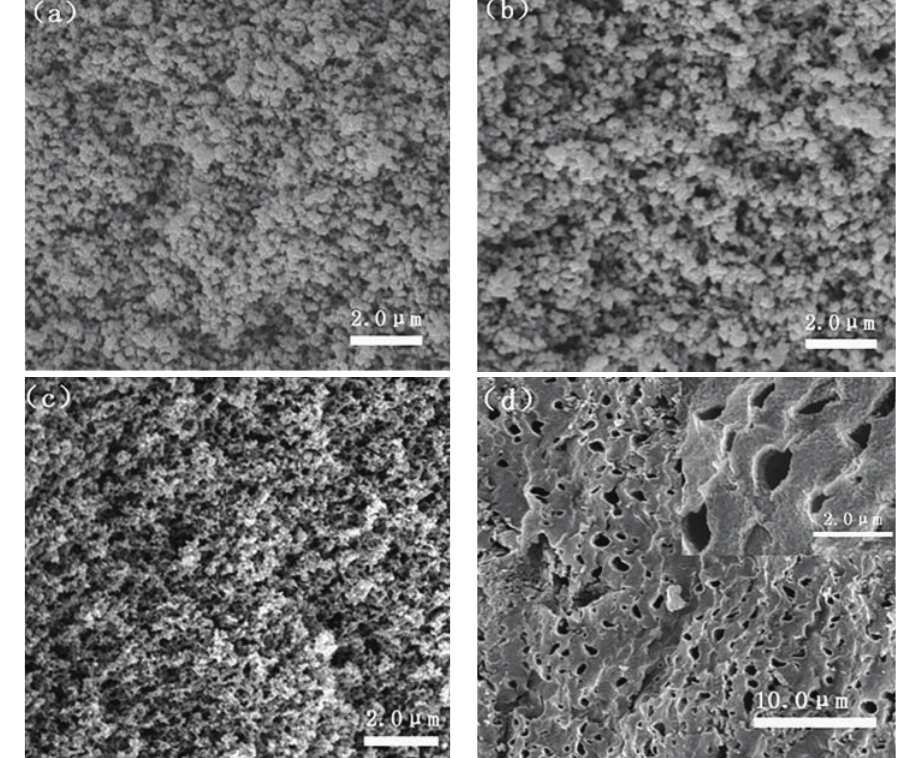
Figure 2: SEM images of TiO 2 aerogel: (a) internal structure of aspherical TiO 2 aerogel-0.1 mL of TBOT, (b) internal structure of aspherical TiO 2 aerogel-0.5 mL of TBOT, (c) internal structure of spherical TiO 2 aerogel-5.0 mL of TBOT, and (d) external surface structure of spherical TiO 2